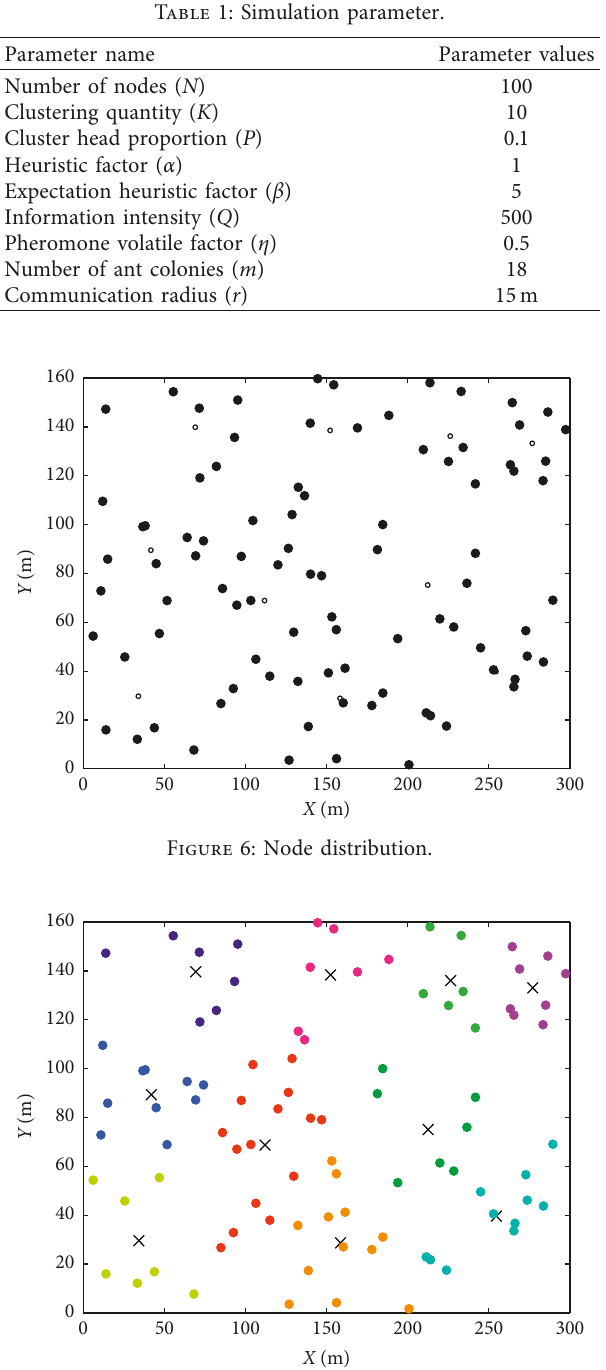
Figure 7: Selection of cluster and cluster head.